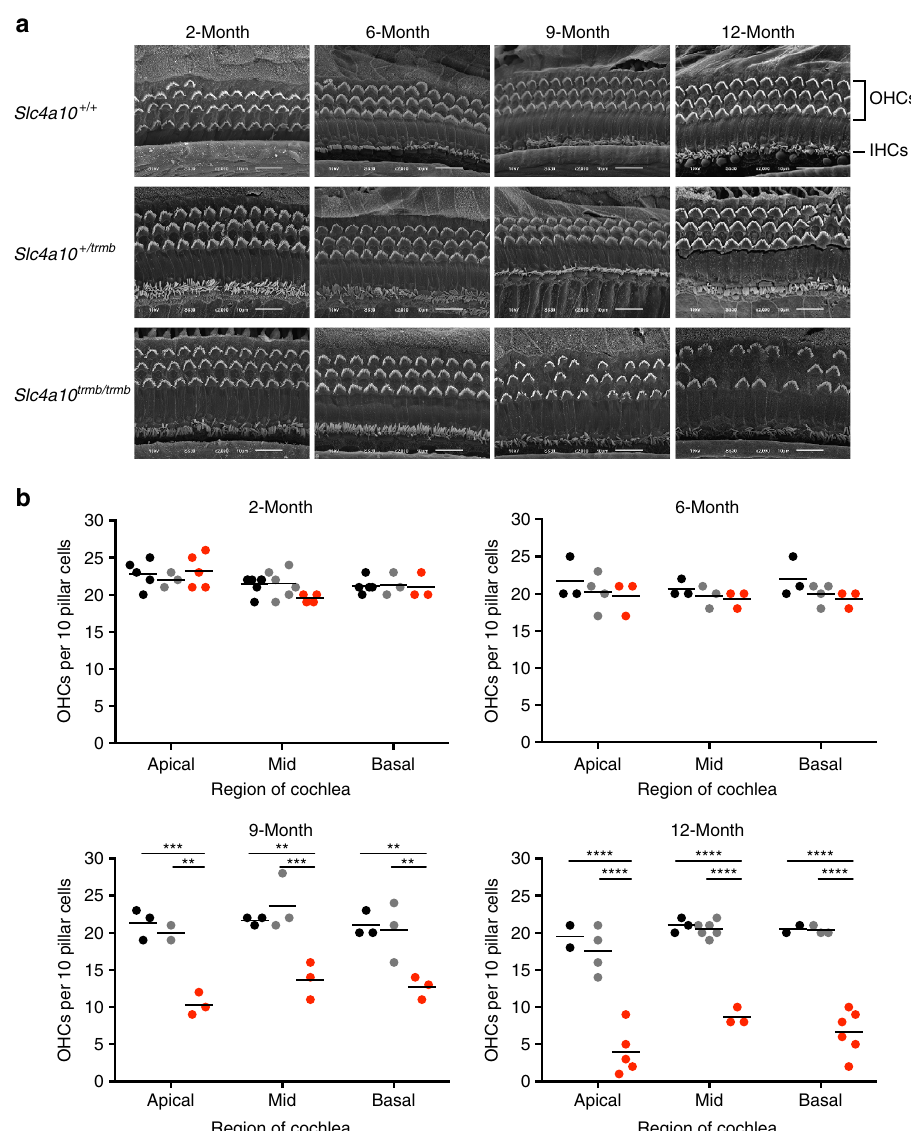
Figure 4 | Ultrastructural analyses of the cochlear sensory epithelium reveals progressive loss of hair cell bundles in trombone mutant mice. ( a ) Scanning Electron Micrographs of the mid-basal coil of the cochlear sensory epithelium from Slc4a10 þ / þ , Slc4a10 þ /trmb , Slc4a10 trmb/trmb mice at 2,